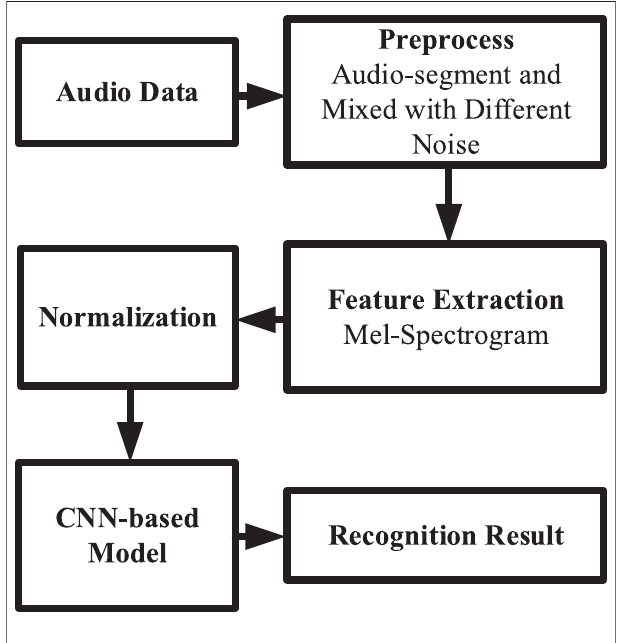
FIGURE 1 | The work- fl ow